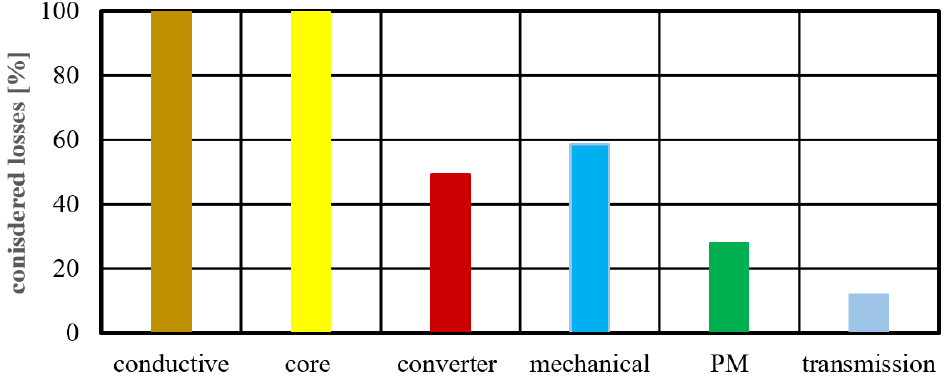
Figure 4. The statistic of documented research focused on the impact of various types of losses on EM of electrical machines during the last three decades (1992 to 2021).